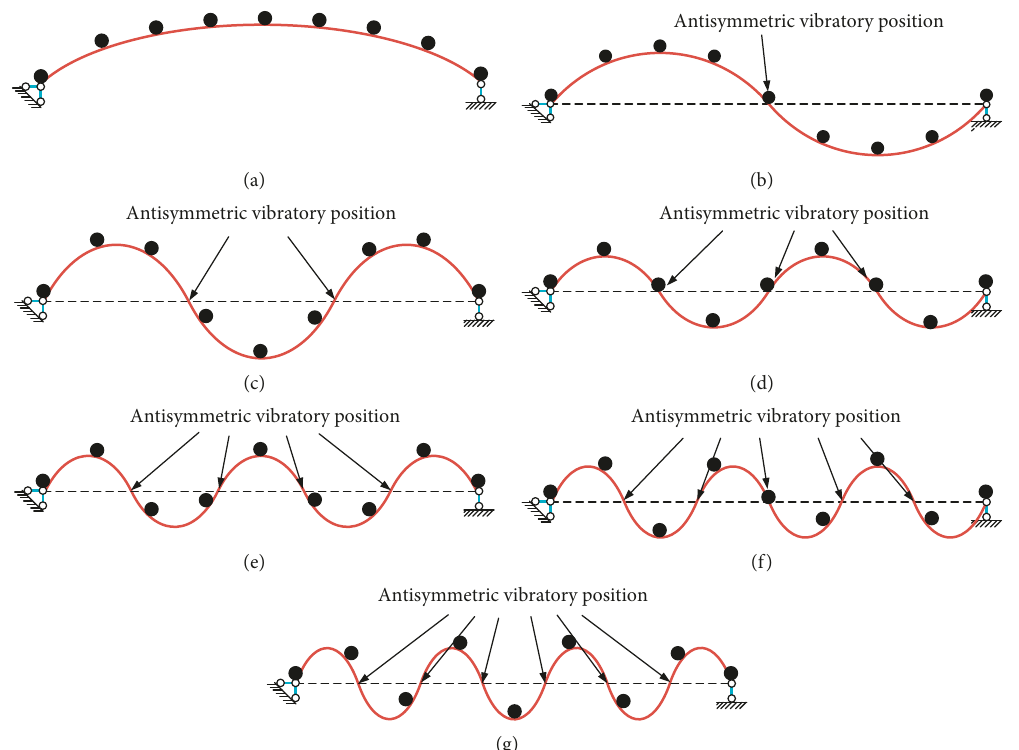
Figure 3: The first seven mode shapes of the simplified model: (a) the 1st mode; (b) the 2nd mode; (c) the 3rd mode; (d) the 4th mode; (e) the 5th mode; (f) the 6th mode; and (g) the 7th